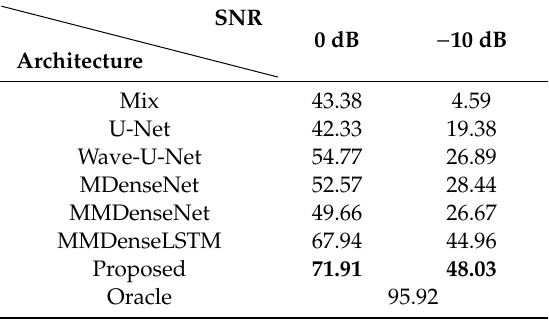
Figure 10. Music identification results and fingerprinting plots at spectrogram. The horizontal axis of the spectrogram represents time (0~12 s) and the vertical axis represents frequency (0~8000 Hz). The matching result and the SDR of the signal are displayed under each plot. The violet line is the fingerprinting of the query, and the black line is the fingerprinting that matches the reference. Table 3. Separation results (dB) on broadcast contents. Table 4. Music identification accuracy